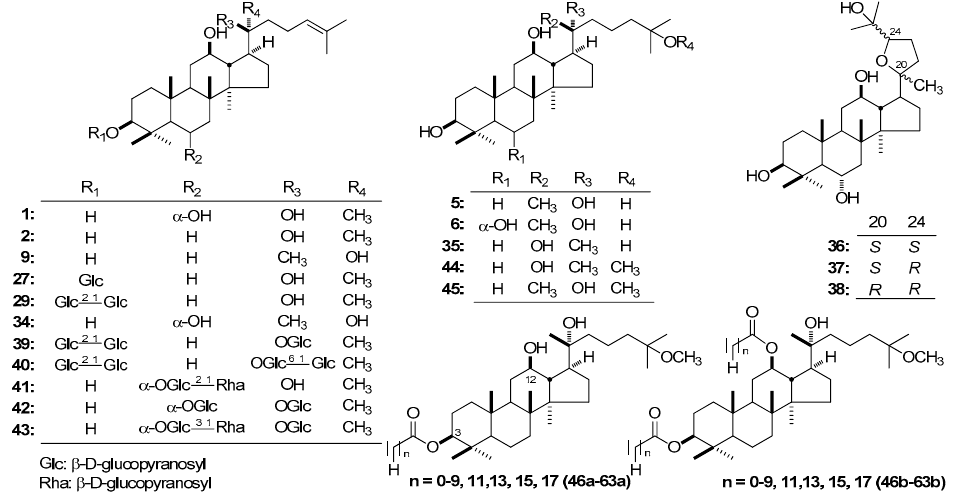
Figure 5. The structure of compounds 1 , 2 , 5 , 6 , 9 , 27 , 29 , 34 – 45, 46a – 63a , and 46b – 63b .